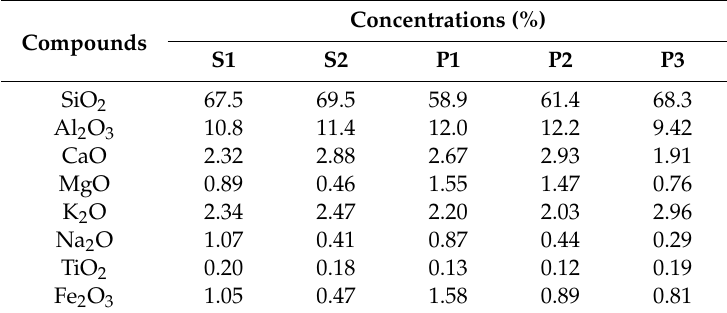
Table 4. Mass fraction in oxides (%) in real samples.